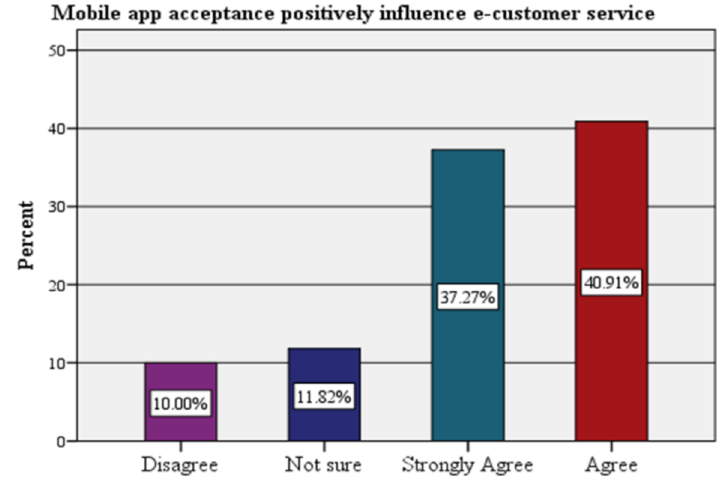
Figure 5. Impact of mobile app acceptance on e-customer service.